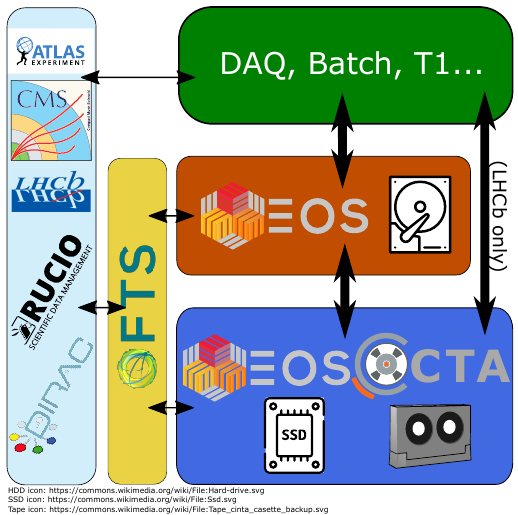
Figure 1. General model of CTA deployment, as followed by ATLAS, CMS and